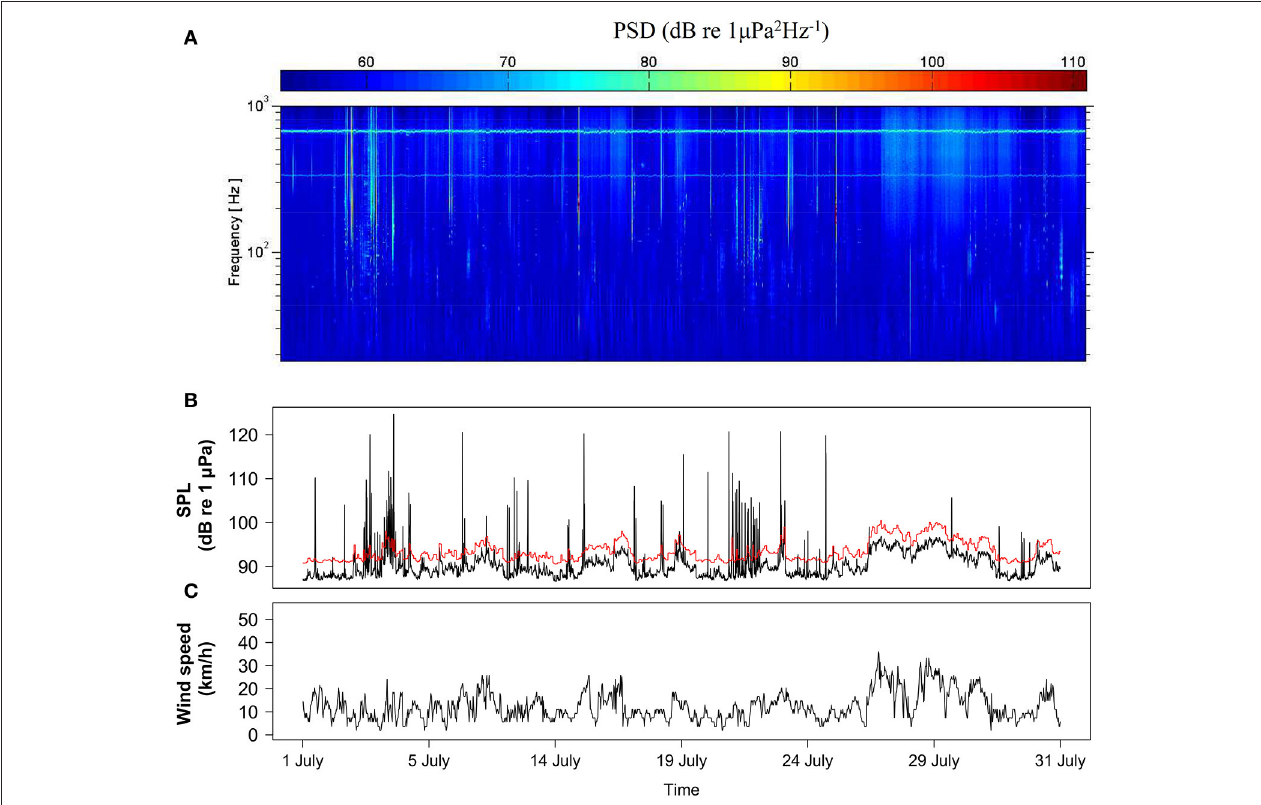
FIGURE 2 | Example of a time-series analysis of intermittent noise for July 2012 at Condor seamount. (A) Spectrogram composed of Power Spectral Densities (PSDs) with 1-s time segments; (B) Broadband (18–1,000 Hz) SPLs measurements and threshold (red line) for boat detection and; (C) 30-min interval wind speed measured in Castelo Branco, Faial